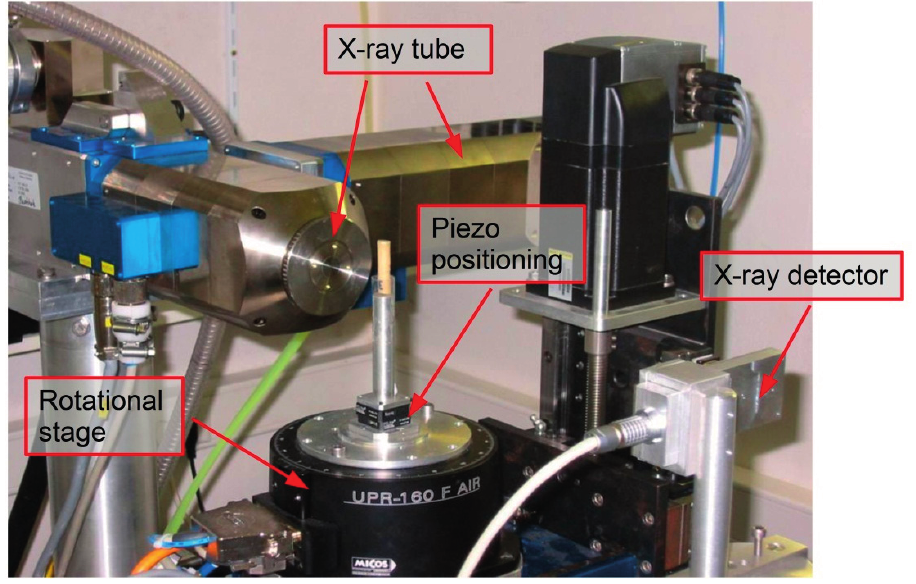
Figure 2. Micro-CT scanning facility from the “Centre for X-ray Tomography” of Ghent University